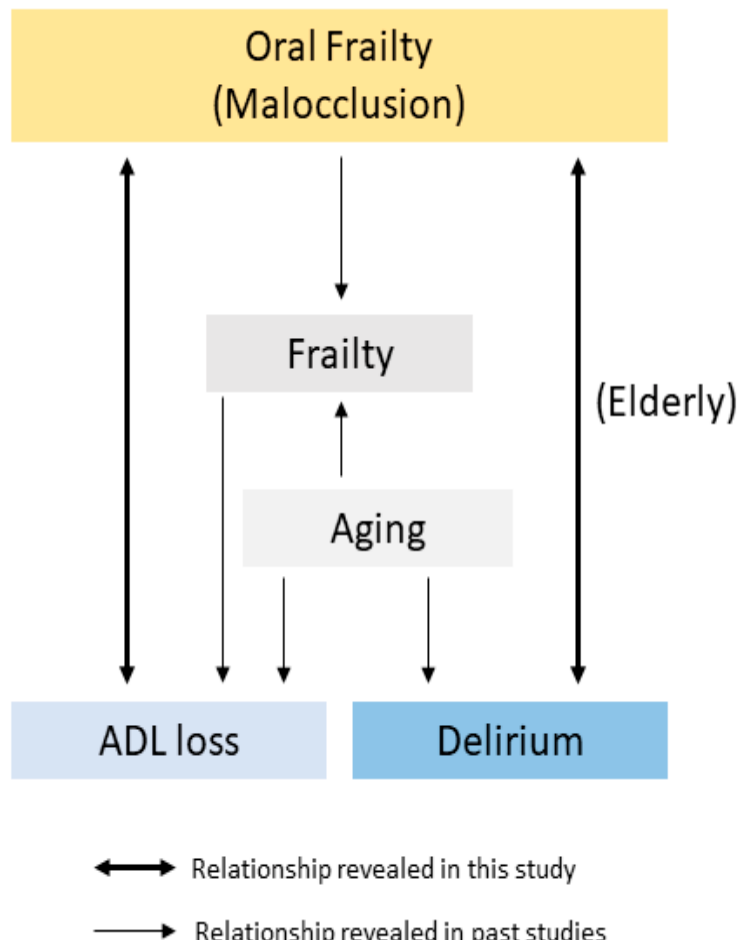
Figure 2. Correlation diagram of Aging, Frailty, and Oral Frailty.